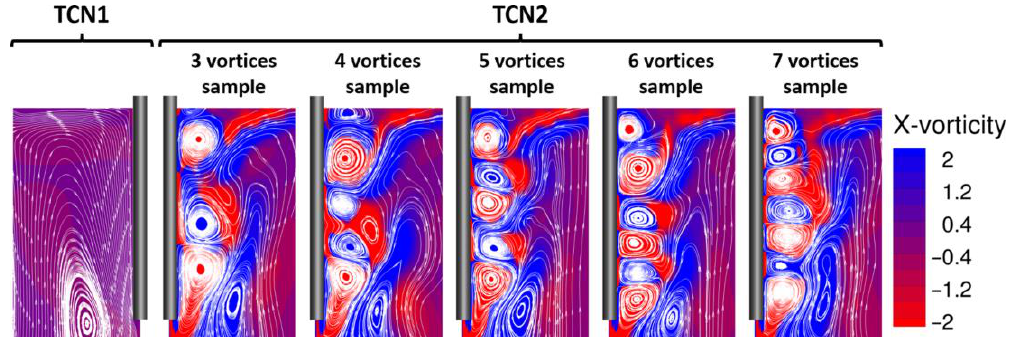
Figure 7. Instantaneous flow structures on an YZ plane superimposed on the X-vorticity field [s − 1 ]. Different samples of flow configurations are reported for the TCN2 case.